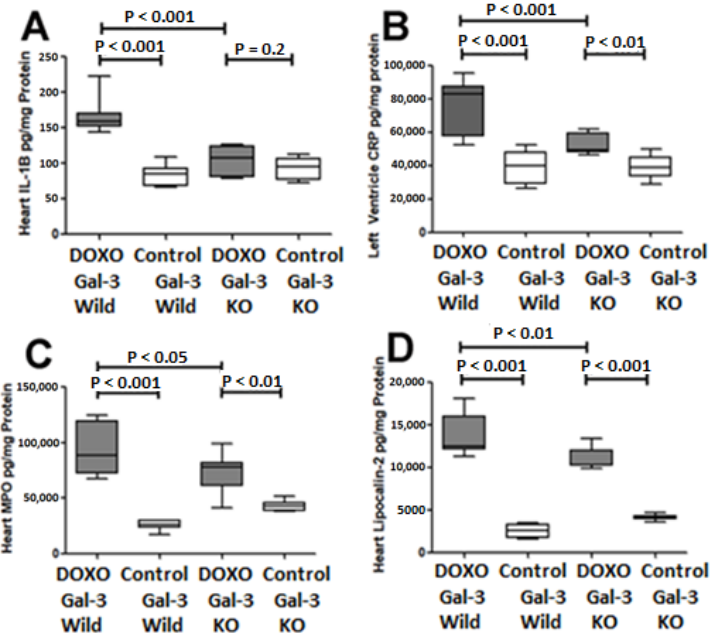
Figure 2. Expression of inflammation markers in DOXO-treated mice. Graphs represent cardiac concentrations of ( A ) IL-1B, ( B ) CRP, ( C ) MPO, and ( D ) lipocalin-2 at 5 days following DOXO treatment in Gal-3 wild type and Gal-3 KO mice compared to sham-treated controls. p -values < 0.05 were considered statistically significant.